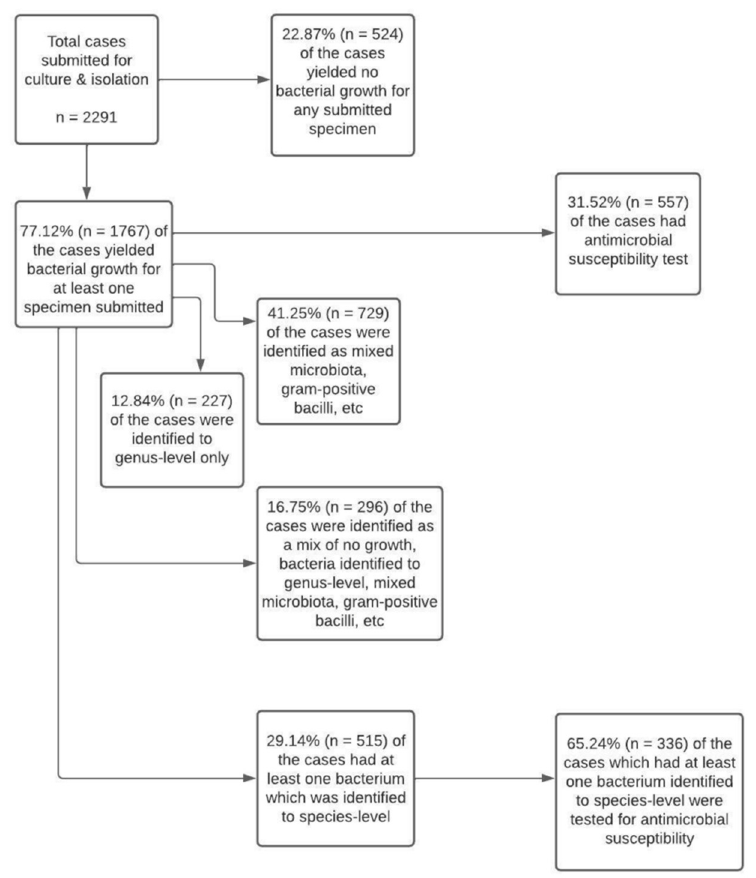
Figure 3. Flowchart summarizing the extent to which salmonid pathogens were identified and cases which had antimicrobial susceptibility test results.